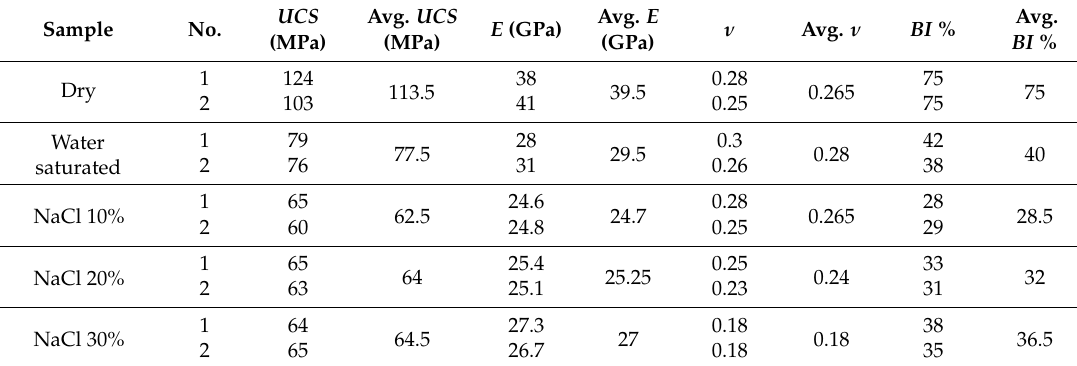
Table 2. Measured and calculated values of siltstone’s mechanical properties.